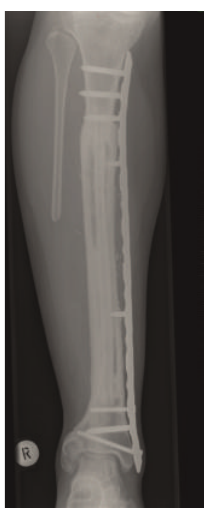
Figure 7: Postoperative AP radiograph at the time of 5-year fol- lowup. Surgery was performed due to multicentric adamantinoma of the right tibia and fibula. The tibial defect was bridged with a homologous tibia allograft and a vascularised fibula autograft.